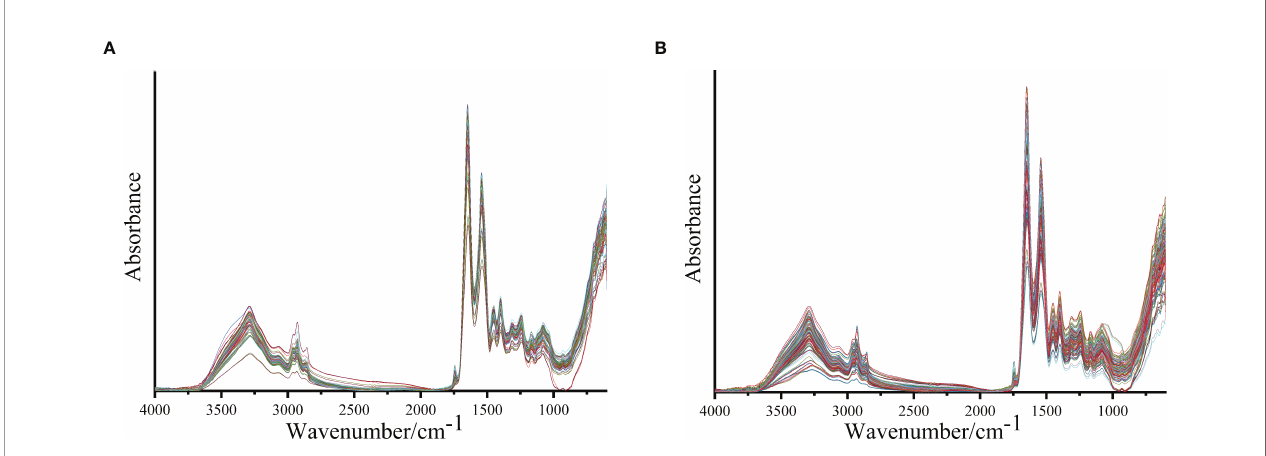
FIGURE 1 | The IR spectra after baseline correction and SG smoothing (9-point) of serum samples from patients with lung cancer (A) and healthy people (B)